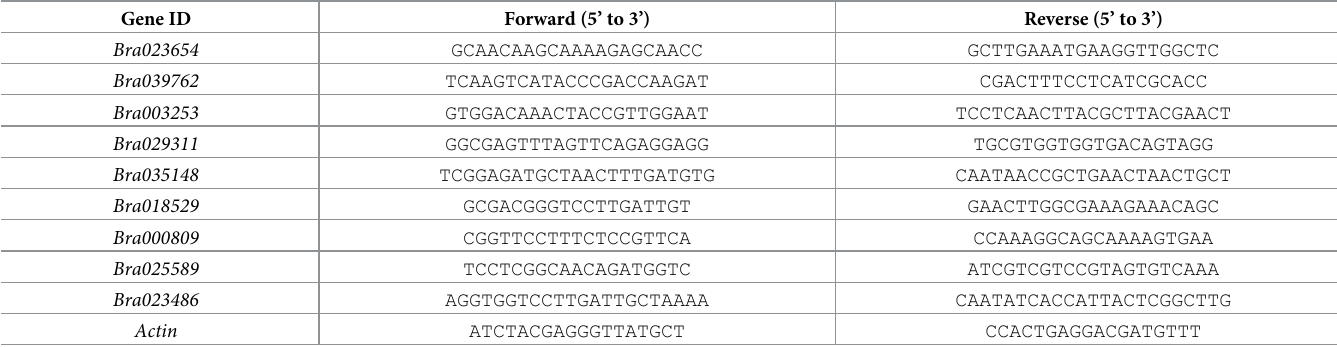
Table 1. qRT-PCR